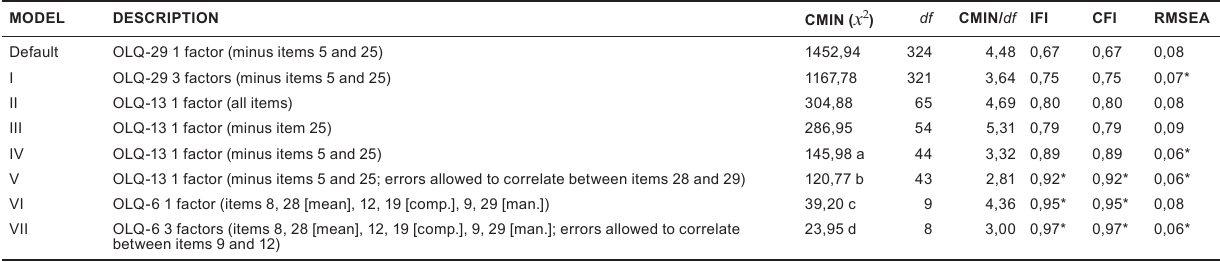
table 2 Orientation to Life Questionnaire (OLQ) construct